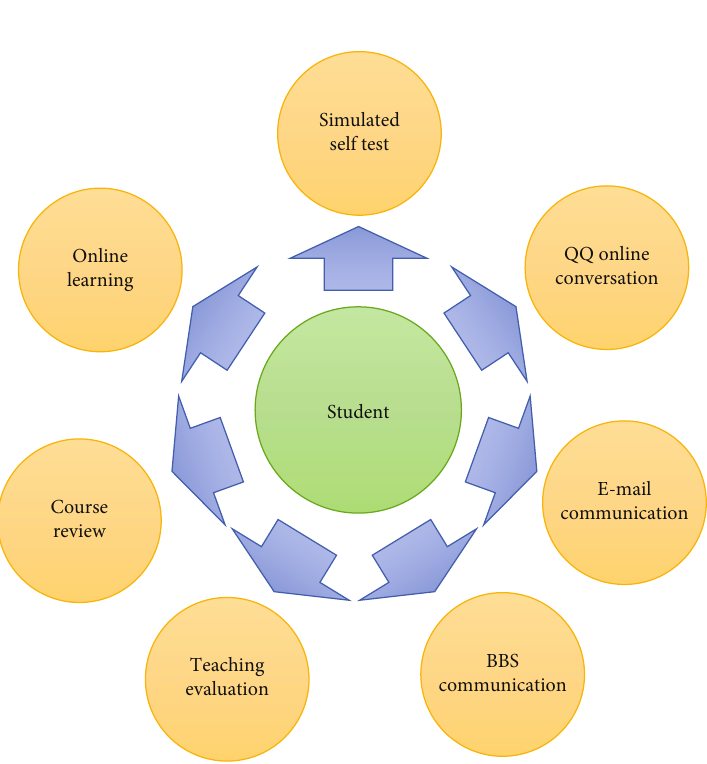
Figure 10: Student function